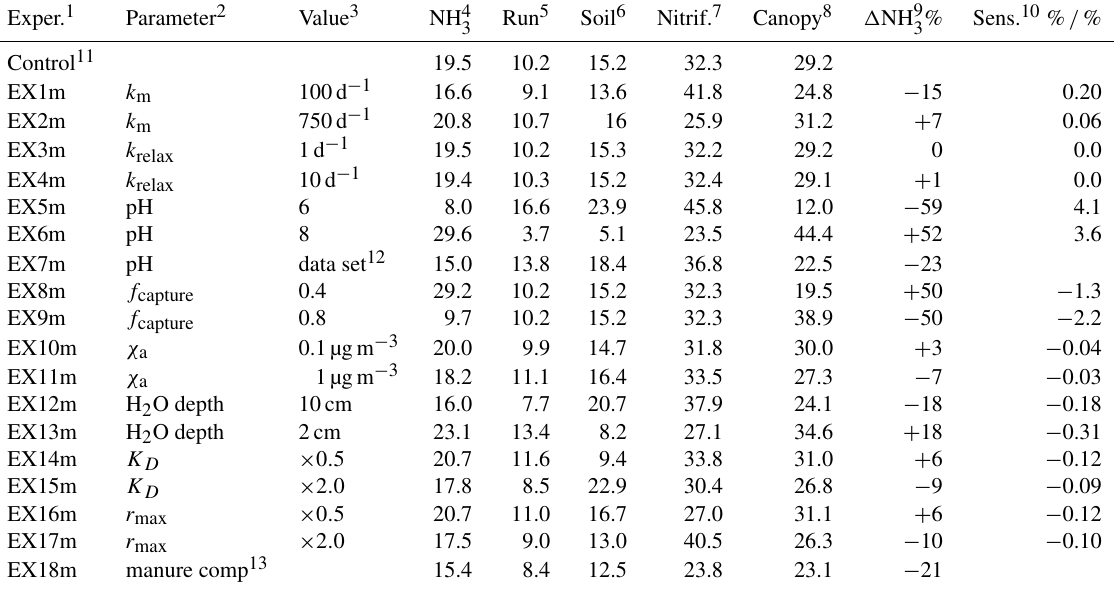
Table 1. Manure sensitivity tests.